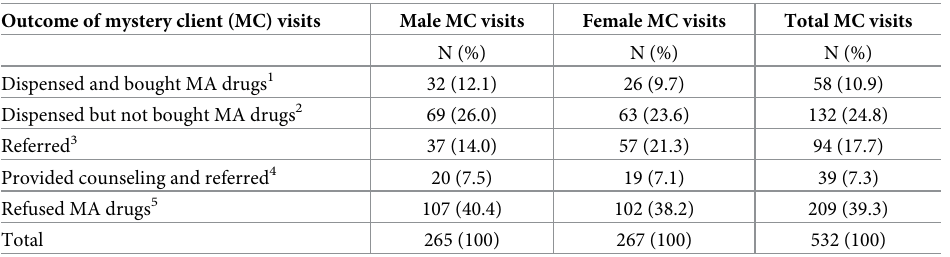
Table 1. Outcome of mystery client visits. Outcome of mystery client (MC)